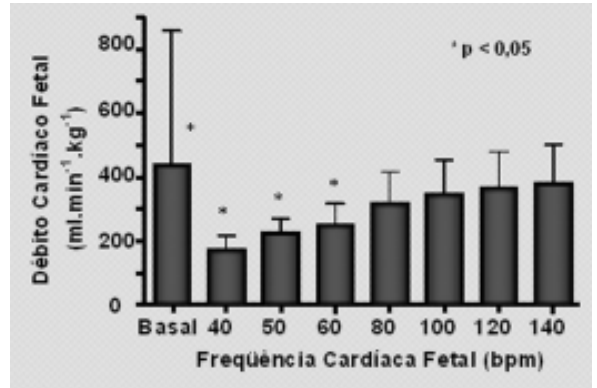
Fig. 3 - Relação do débito cardíaco fetal com a freqüência cardíaca fetal. n = 5, Valores = média ± desvio padrão Teste de Friedman: